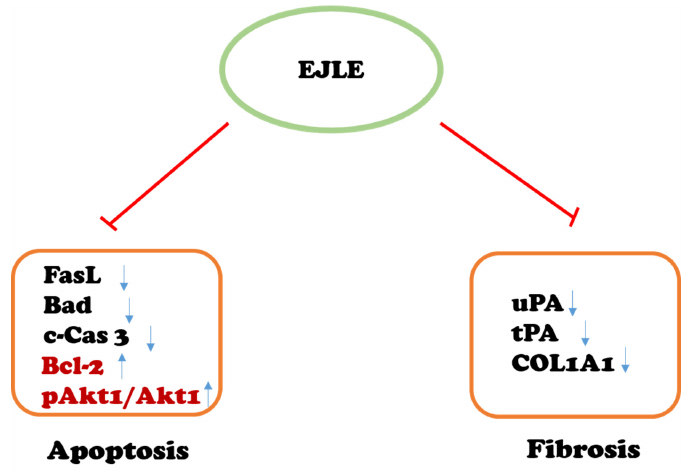
Figure 7. Schematic outline representing the effect of EJLE on cardiac apoptosis mediators (FasL, Bad, c-Cas 3, and anti-apoptotic/survival markers Bcl2 and Akt1) and fibrosis mediators (uPA, tPA, COL1A1) in model animals. Arrow represents proteins modulated by EJLE. The T bar represents attenuation of cardiac apoptosis and fibrosis through supplementation of EJLE, whereas the upward and downward arrows represent the protein expressions pattern.